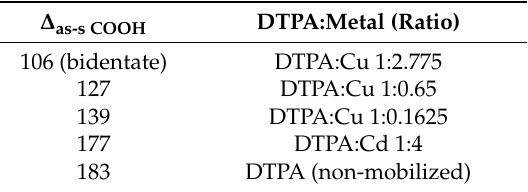
Figure A2. Thermograms of Fe 3 O 4 /SiO 2 -NH 2 ( a ) and Fe 3 O 4 /SiO 2 -NH 2 -DTPA ( b ) nanocomposites. Table A2. Shifts for carboxylate AB for the Fe 3 O 4 /SiO 2 -NH 2 - DTPA-Cu/Cd nanocomposites.